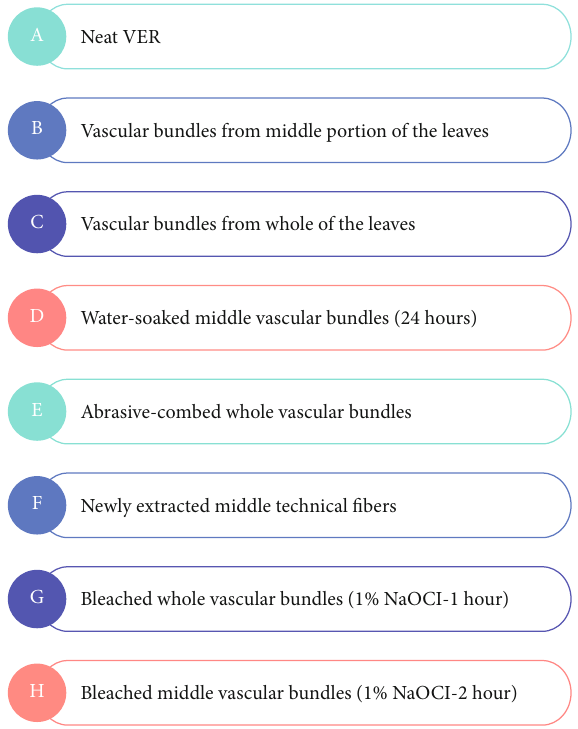
Figure 1: Pineapple leaf fi ber sample designations and